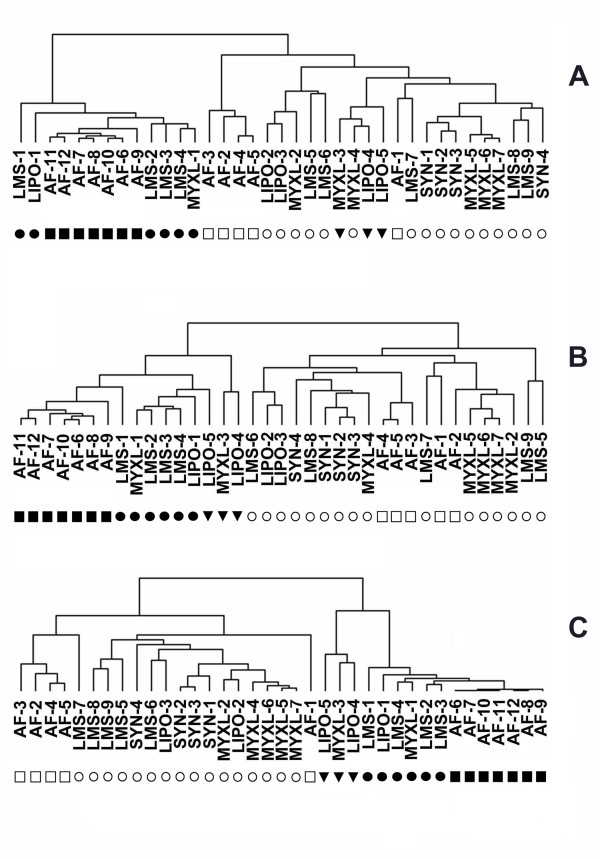
Clustering of gene expression of the STS and AF samples with the RCC gene set (A), OVCA gene set (B), and AF gene set (C). The 12 AF samples and the 25 other STS samples were clustered using the Eisen clustering software Cluster as described in the text. The 16 samples that cluster with AF-1 to AF-5 (open squares) using all 3 gene sets are indicated by open circles. The 6 samples that cluster with AF-6 to AF-12 (solid squares) using all 3 gene sets are indicated by closed circles. The clustering of 3 samples (solid triangles) varied with the gene set. The tissue samples in the tree are joined by very short branches if they have gene expression patterns that are very similar to each other, and by increasingly longer branches as their similarity decreases.